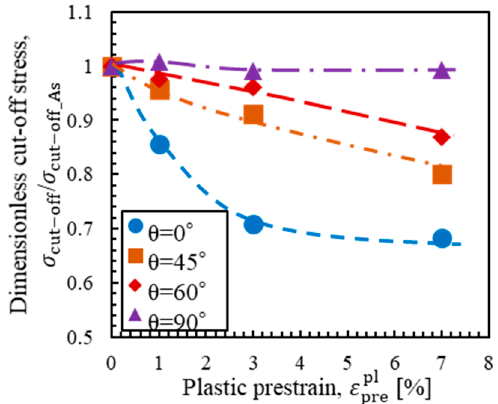
Figure 7. Change in the dimensionless cut-off stress due to prestrain in different directions.